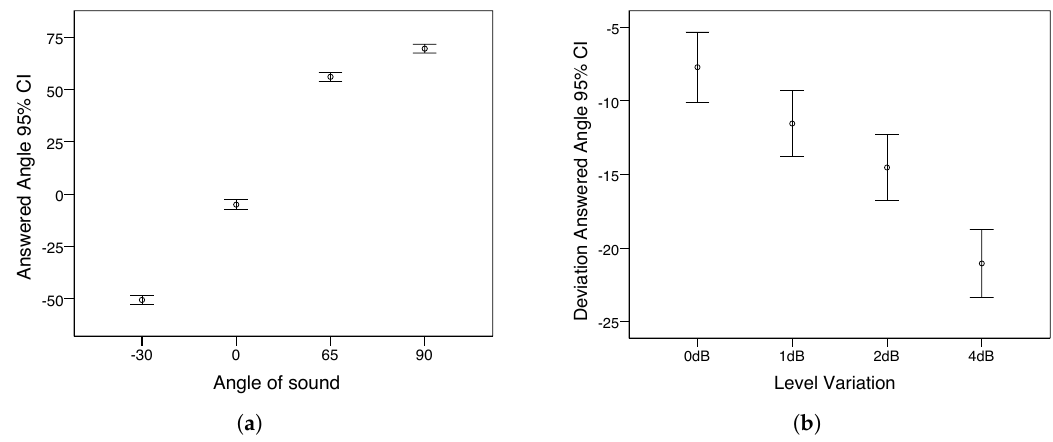
Figure 4. ( a ) Average of the answered angles versus reproduced angles (degrees); ( b ) average of the deviation of the answered angles (degrees) versus level variation